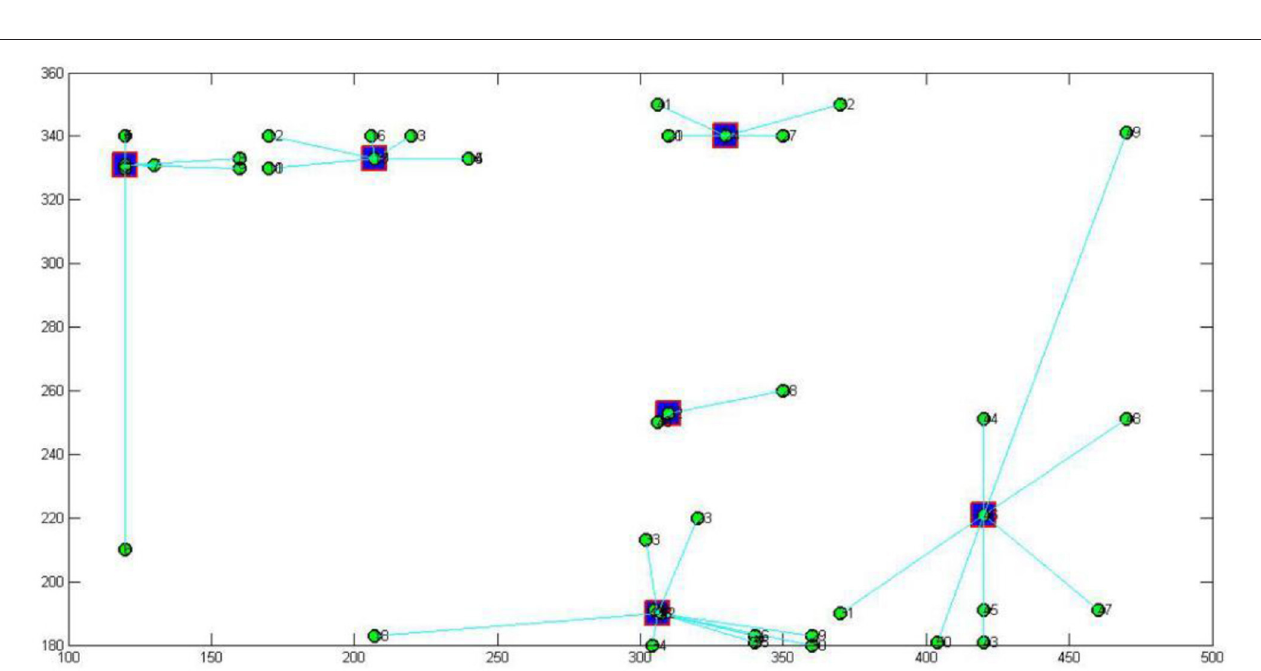
FIGURE 7 | Key Nodes in the Distribution Network of Case